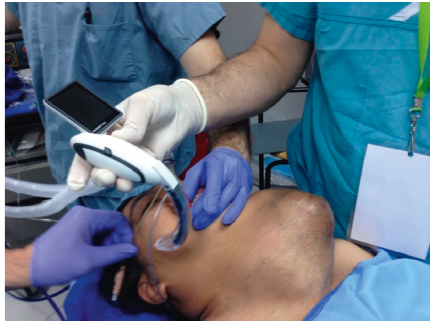
Figure 4: Neglected goiter presenting with difficult airways.